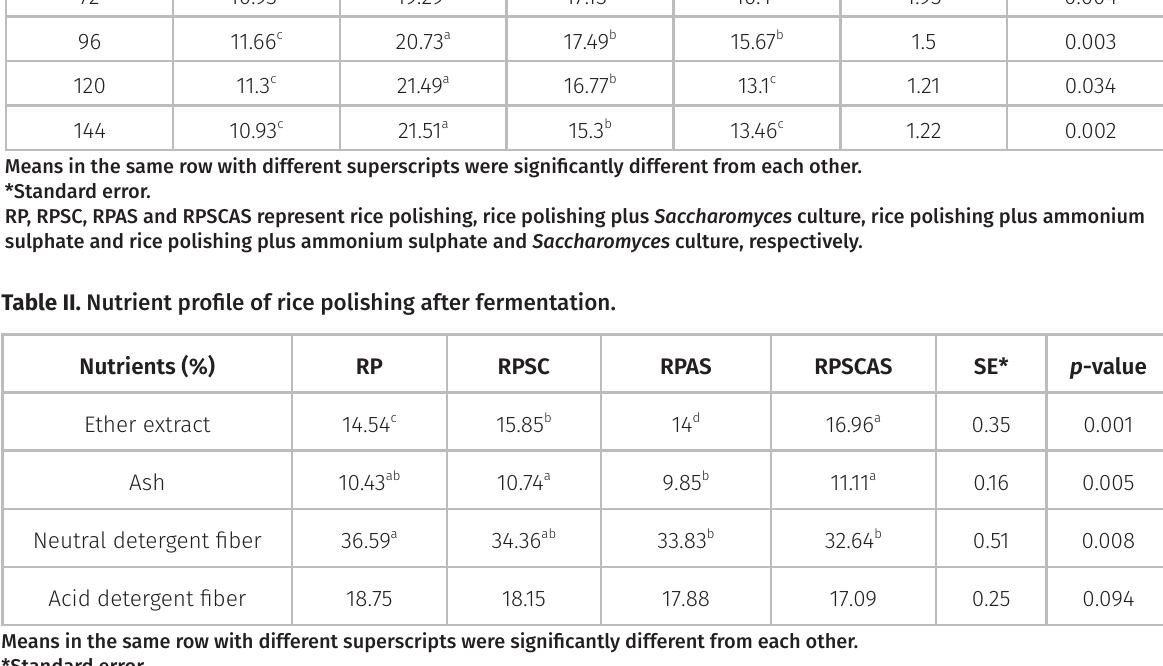
Table I. Crude protein content of rice polishing at different periods of fermentation. Hours